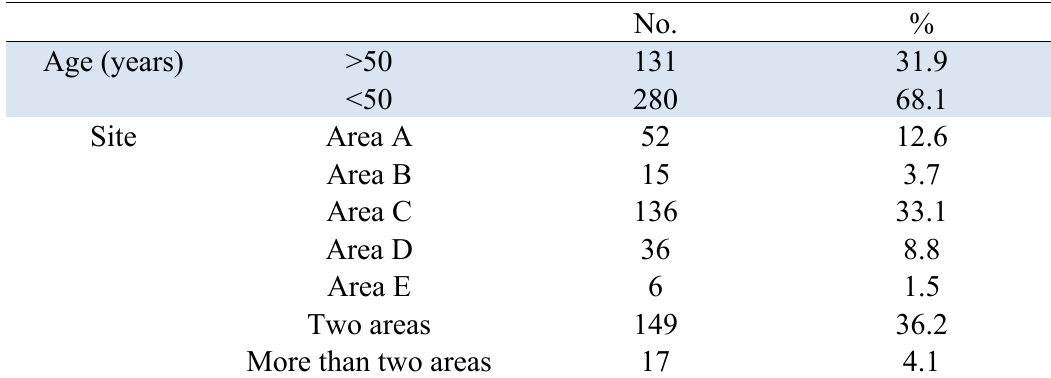
Table 1. Patients and tumor